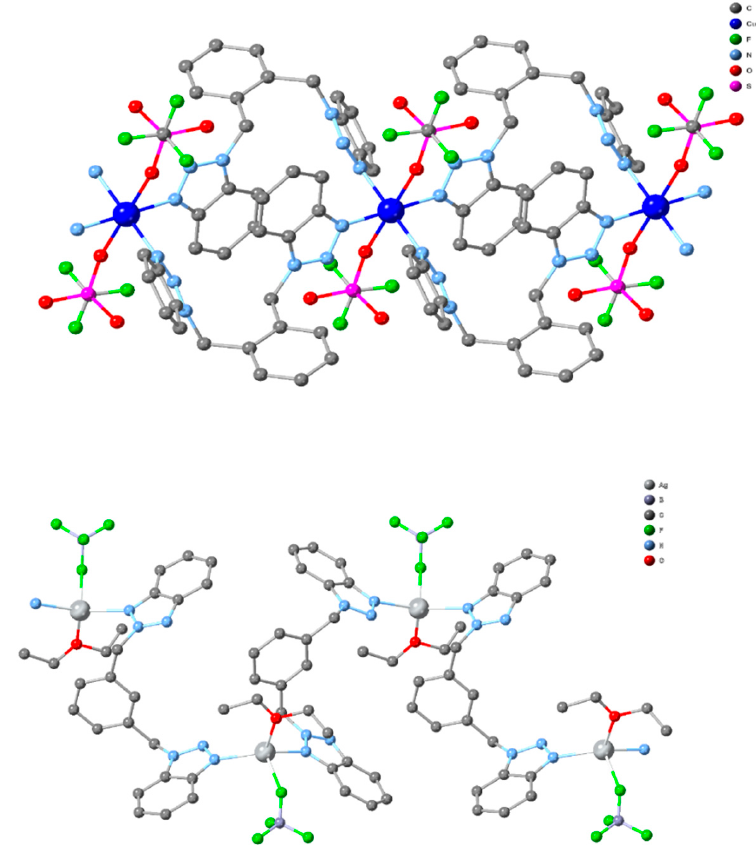
Figure 2. Compound 7 ( upper ) and compound 8 ( lower ).